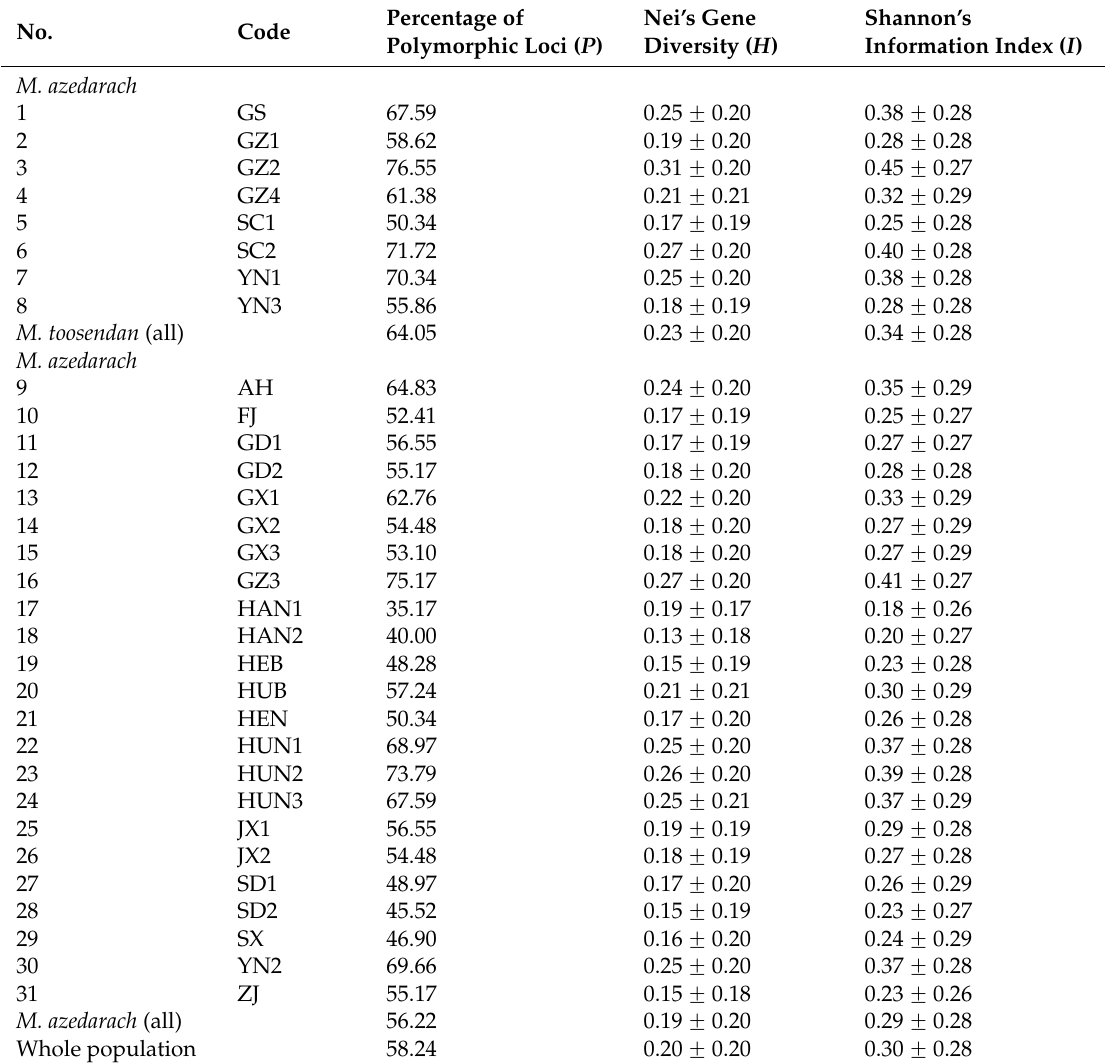
Table 4. Genetic diversity in 31 Melia